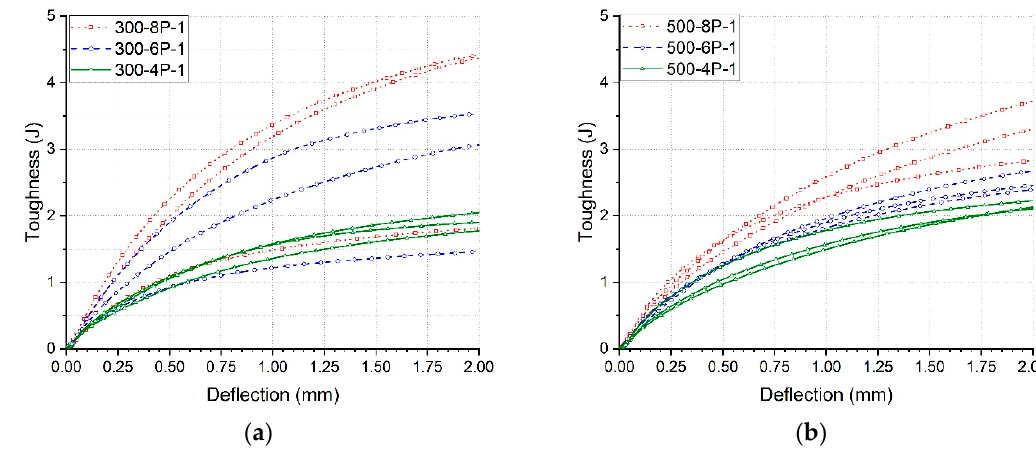
Figure 9. Cumulative toughness of the bamboo fiber reinforced specimens up to 2 mm deflection: ( a ) 300 μ m batch; ( b ) 500 μ m batch evaluated from the four-point bending test according to ASTM C1609 [52].